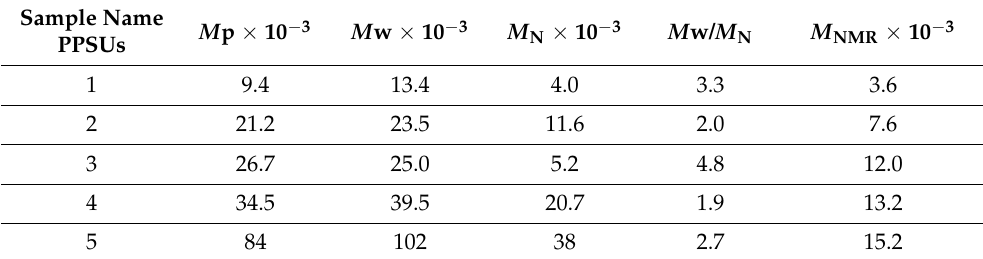
Table 5. Molecular weight and molar mass distribution of PPSUs determined by the GPC method and by estimates made based on the NMR